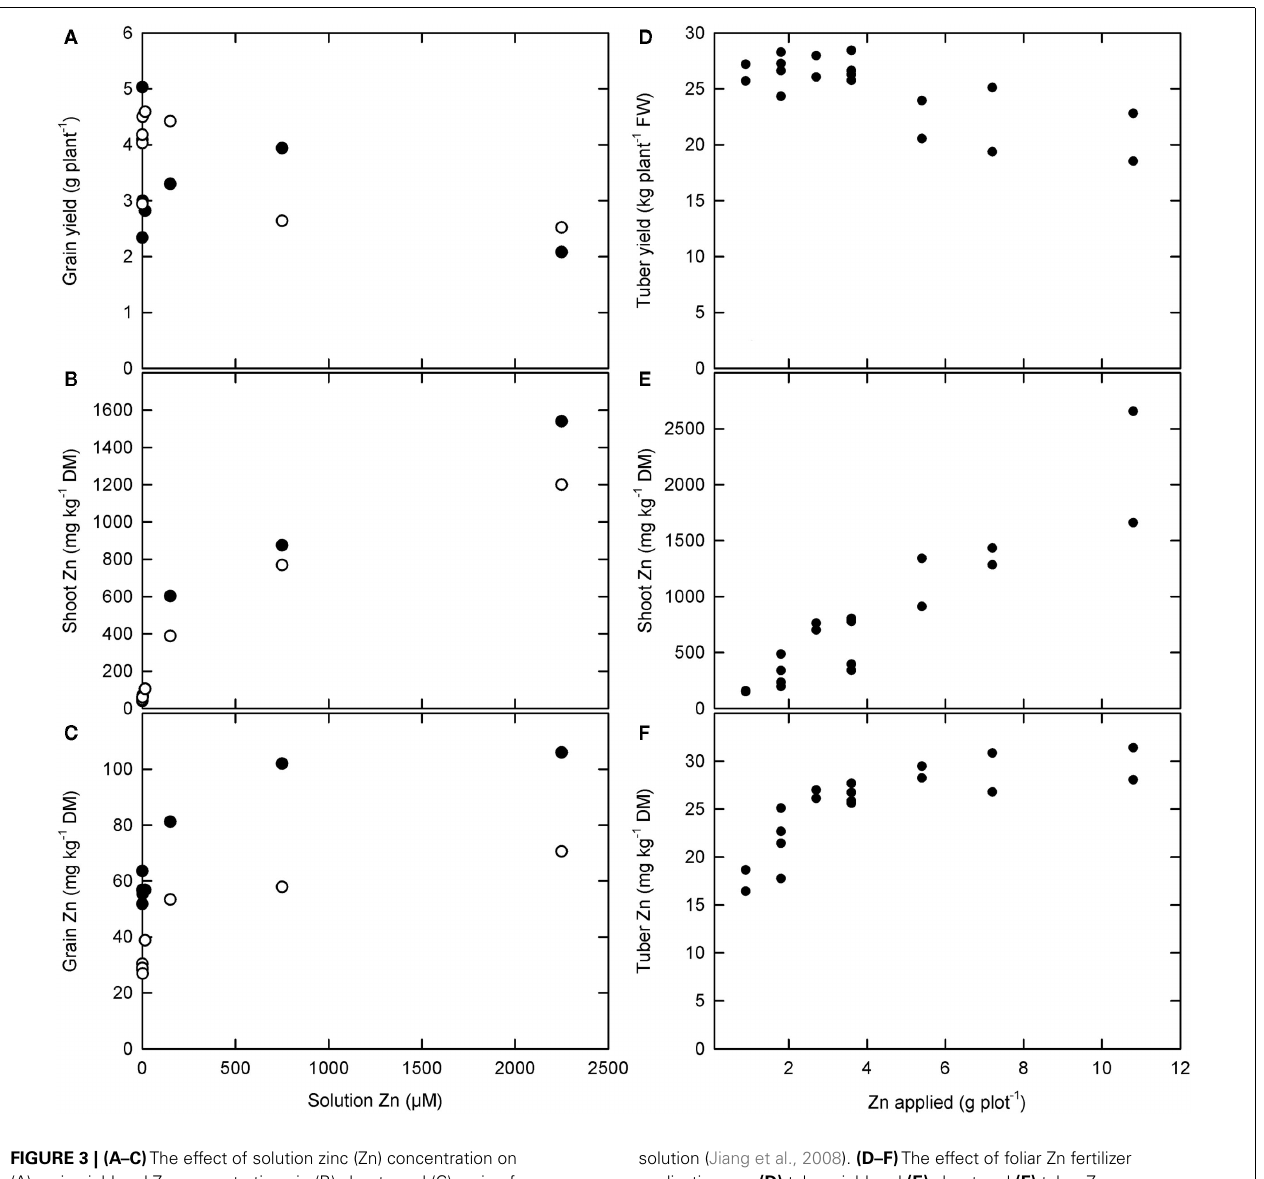
FIGURE 3 | (A–C) The effect of solution zinc (Zn) concentration on (A) grain yield and Zn concentrations in (B) shoots and (C) grain of two rice varieties, Handao297 (filled circles) and K150 (open circles), grown in quartz sand irrigated with a complete nutrient